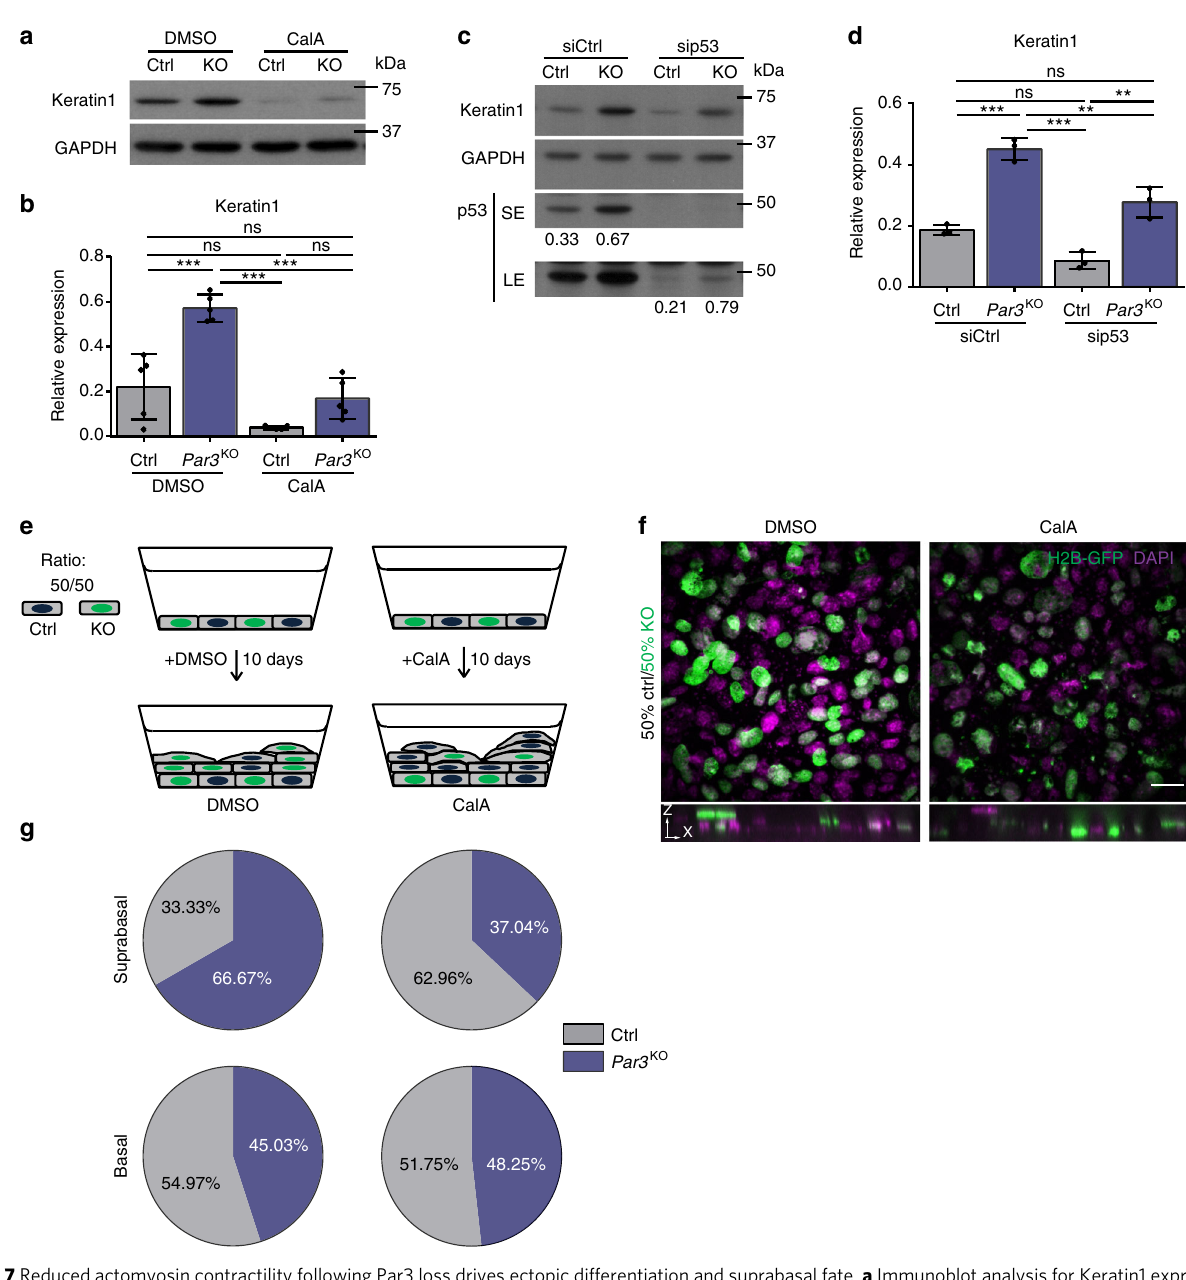
Fig. 7 Reduced actomyosin contractility following Par3 loss drives ectopic differentiation and suprabasal fate. a Immunoblot analysis for Keratin1 expression in keratinocyte lysates following 48 h CalA (1 nM) treatment. GAPDH served as loading control. b Quanti fi cation of a . Keratin1 levels were fi rst normalized to GAPDH and then expressed as relative values. n = 5 biological independent samples; *** p = 0.001 (Ctrl vs. Par3 KO, DMSO-treated); *** p = 0.0003 ( Par3 KO, DMSO-treated vs. CalA-treated), *** p < 0.0001 ( Par3 KO/DMSO-treated vs. Ctrl/CalA-treated), mean ± SD, two-way ANOVA/Tukey ’ s multiple comparisons test. c Immunoblot analysis for Keratin1 expression in keratinocyte lysates following siCtrl or sip53 transfection. GAPDH served as loading control. Relative p53 protein levels are shown below the immunoblot. d Quanti fi cation of c . Keratin1 levels were fi rst normalized to GAPDH and then expressed as relative values. n = 3; *** p = 0.0009 (Ctrl vs. Par3 KO, siCtrl-treated); *** p = 0.0001 ( Par3 KO siCtrl-treated vs. Ctrl sip53-treated); ** p = 0.008 ( Par3 KO siCtrl-treated vs. sip53-treated); ** p = 0.0049 (Ctrl sip53-treated vs. Par3 KO sip53-treated); mean ± SD; two-way ANOVA/Tukey ’ s multiple comparisons test. e Schematic representation of the Transwell fi lter culture system and experimental setup. Par3 KO keratinocytes were positive for H2B-GFP, control keratinocytes isolated from littermates were negative for H2B-GFP. f Immuno fl uorescence micrographs of strati fi ed cultures incubated for 10 days either in DMSO or in 1 nM CalA. Par3 KO keratinocytes were H2B-GFP (green) labeled, DAPI is shown in magenta. Bottom panels show zx-projection. Scale bar: 50 µ m. g Pie graphs showing cell distribution according to basal or suprabasal position following a 10-day culture period of mixed control and Par3 KO keratinocyte cultures on Transwell fi lters. DMSO-treated samples: n = 180 cells (basal/DMSO-treated: n = 171 cells; suprabasal/DMSO-treated: n = 9 cells); CalA-treated samples: n = 170 cells (basal/CalA-treated: n = 143 cells; suprabasal/CalA-treated: n = 27 cells). An experimental representaton of three independent experiments is shown. Cropped immunoblot data are shown. Image intensity was enhanced for better visualization. Ctrl control, KO Par3 KO, CalA Calyculin A, ns non-signi fi cant, SE short exposure, LE long exposure, siCtrl small interfering non-targeting RNAs, sip53 small interfering RNAs targeting